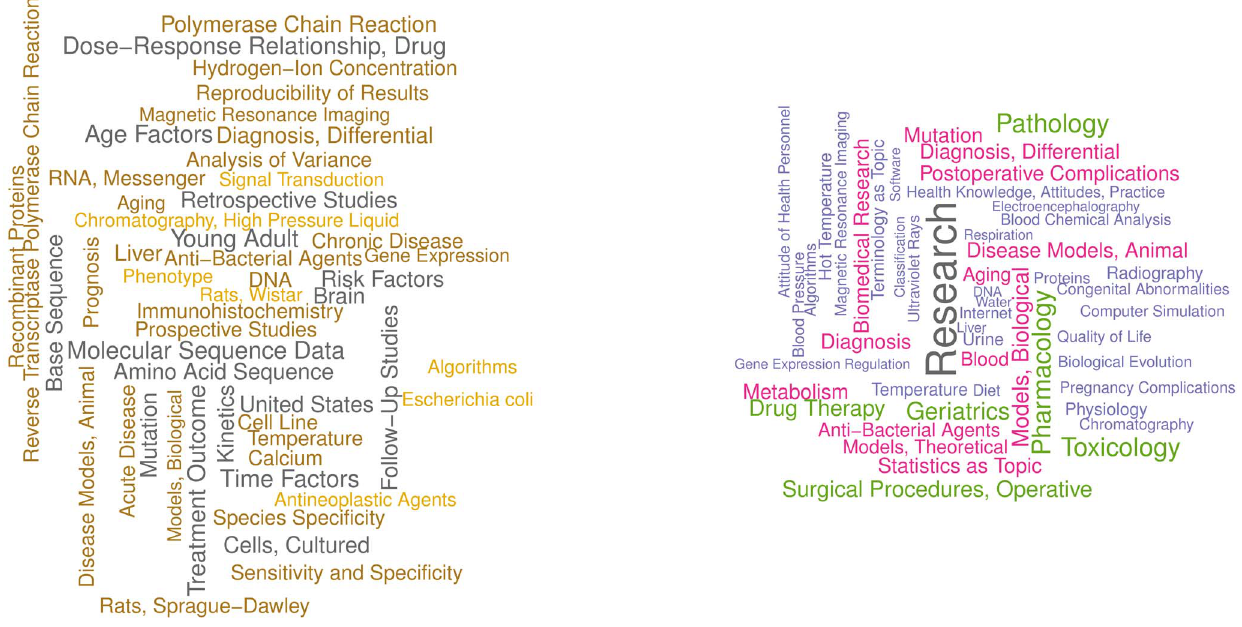
Figure 3. Wordcloud. Visual summary with 50 top degree MeSH descriptors for full (left figure) and major (right figure) MeSH networks. The text size is proportional to the node degree.